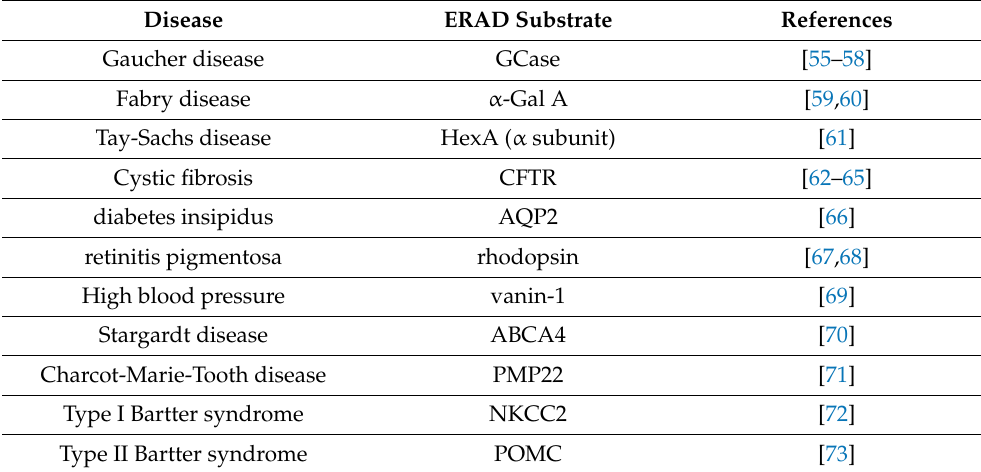
Table 1. ERAD-dependent degradation of responsible proteins in hereditary diseases.